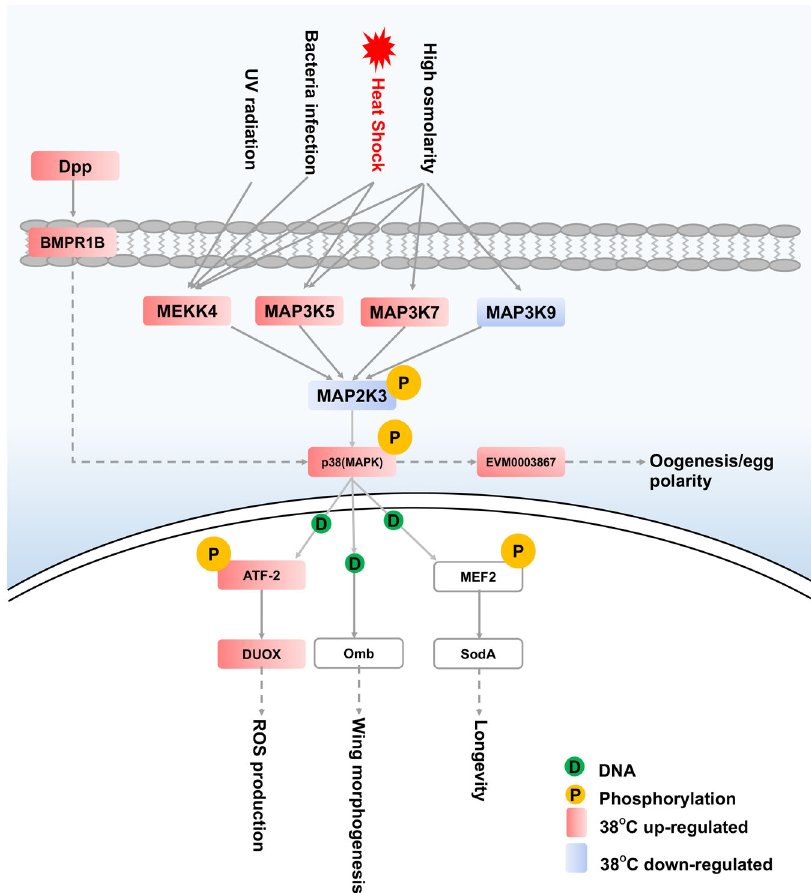
Fig. 4 P38 MAPK pathway in Bactrocera dorsalis . The activation of p38 mitogen-activated protein kinase regulates a variety of processes through various signalling pathways in B. dorsalis . The circles with ‘ D ’ and ‘ P ’ indicate DNA and phosphorylation, respectively, while the red and blue arrows represent up- and downregulation after treatment at 38